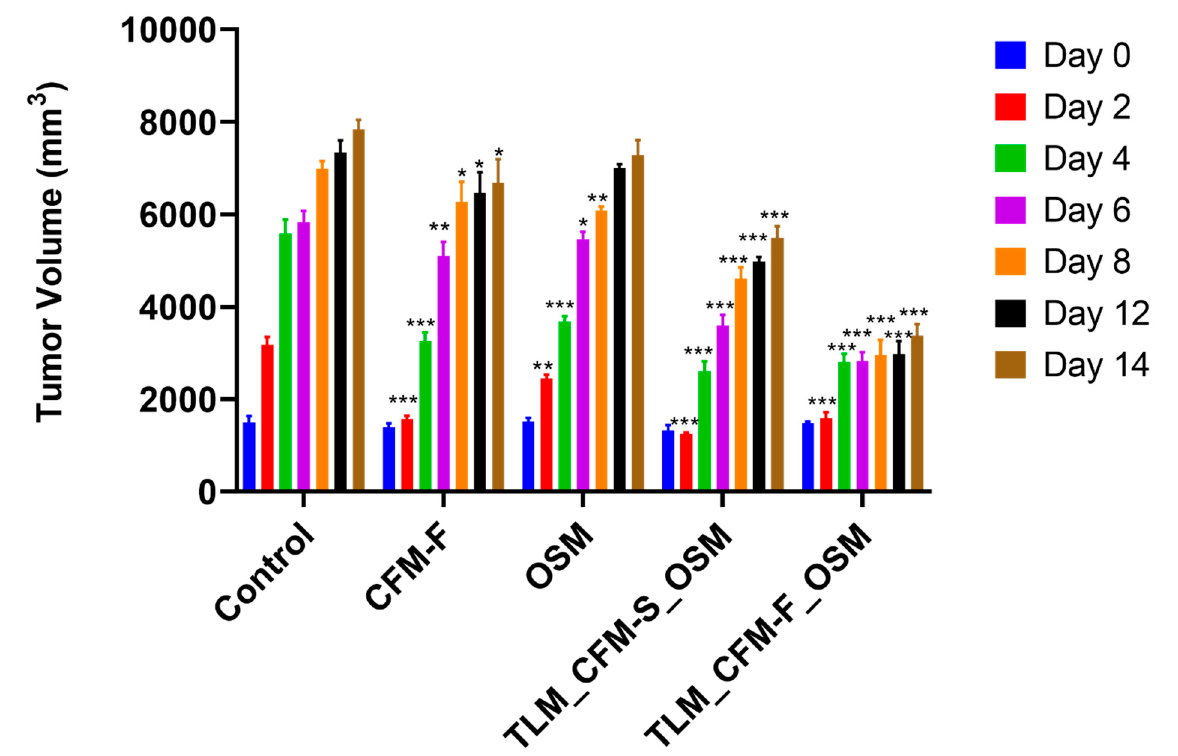
Figure 1. The effect of Telmisartan, CFM-F, and Osimertinib on tumor volume in experimental NSCLC. Histogram demonstrating the H1975 tumor volumes in athymic nude mice after treatment with Osimertinib (OSM), CFM4.17 lipid formulation (CFM-F), CFM4.17 solution (CFM-S), Telmisartan (TLM) and their combinations. Data were represented as the mean ± SD of three separate experiments ( n = 3). *** p < 0.001, ** p < 0.01 and * p < 0.05 vs.